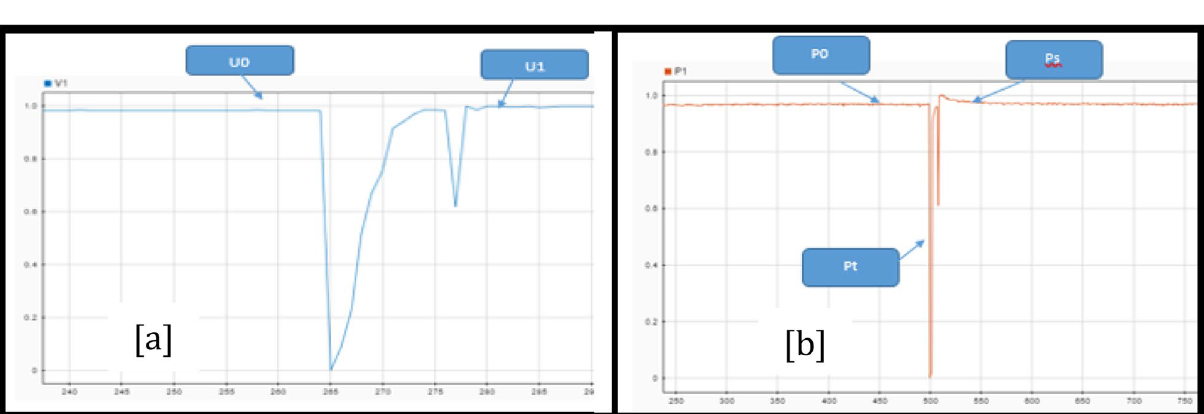
Figure 19. Voltage variation ( a ) and Power variation ( b ) during a disturbance at Policentro bus.